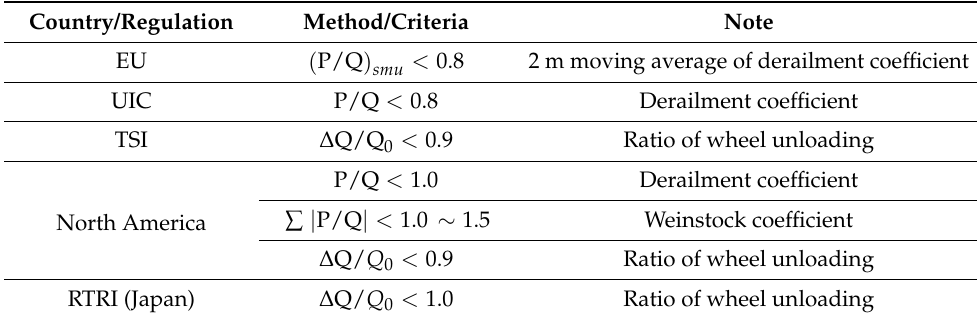
Table 9. The various evaluation criteria of